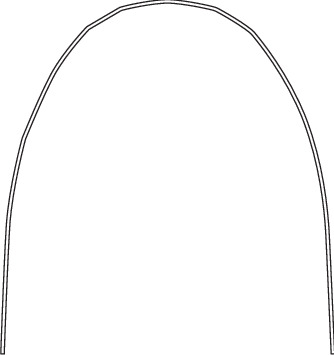
Standard oval loop.